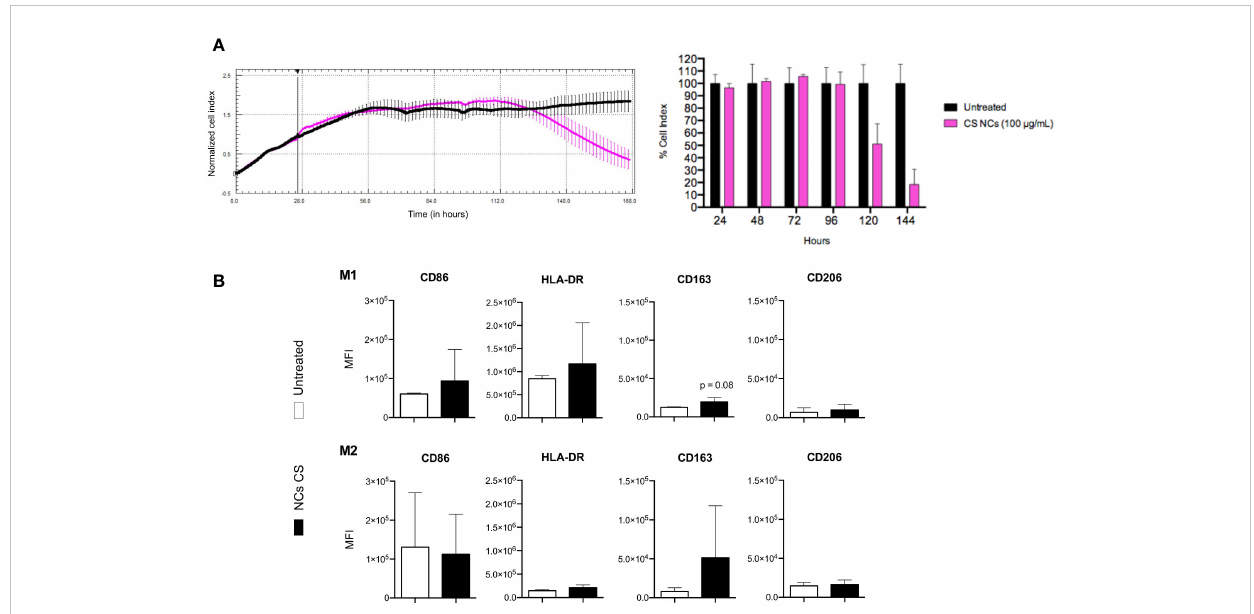
FIGURE 3 Effect of CS NCs in tumor cells in vitro. (A) Kinetics of the normalized cell index of ATQ303G in the presence of the CS NCs (left) and the cell index quanti fi cation (right). Untreated cells (black color) were used as control. (B) Modulation of marker expression on THP-1 cells differentiated to M1 and M2 after incubation with RMPI culture medium (white color) or CS NCs (black color) at 100 µg/mL for 24 h. The values are normalized to those obtained for the differentiated M1 and M2. For differentiation to M1, THP-1 cells were incubated for 48 h with 20 ng/mL IFN- g + 5 ng/mL LPS + 10 ng/mL of GM-CSF, while for M2 they were incubated with 20 ng/mL IL-4 + 10 ng/mL